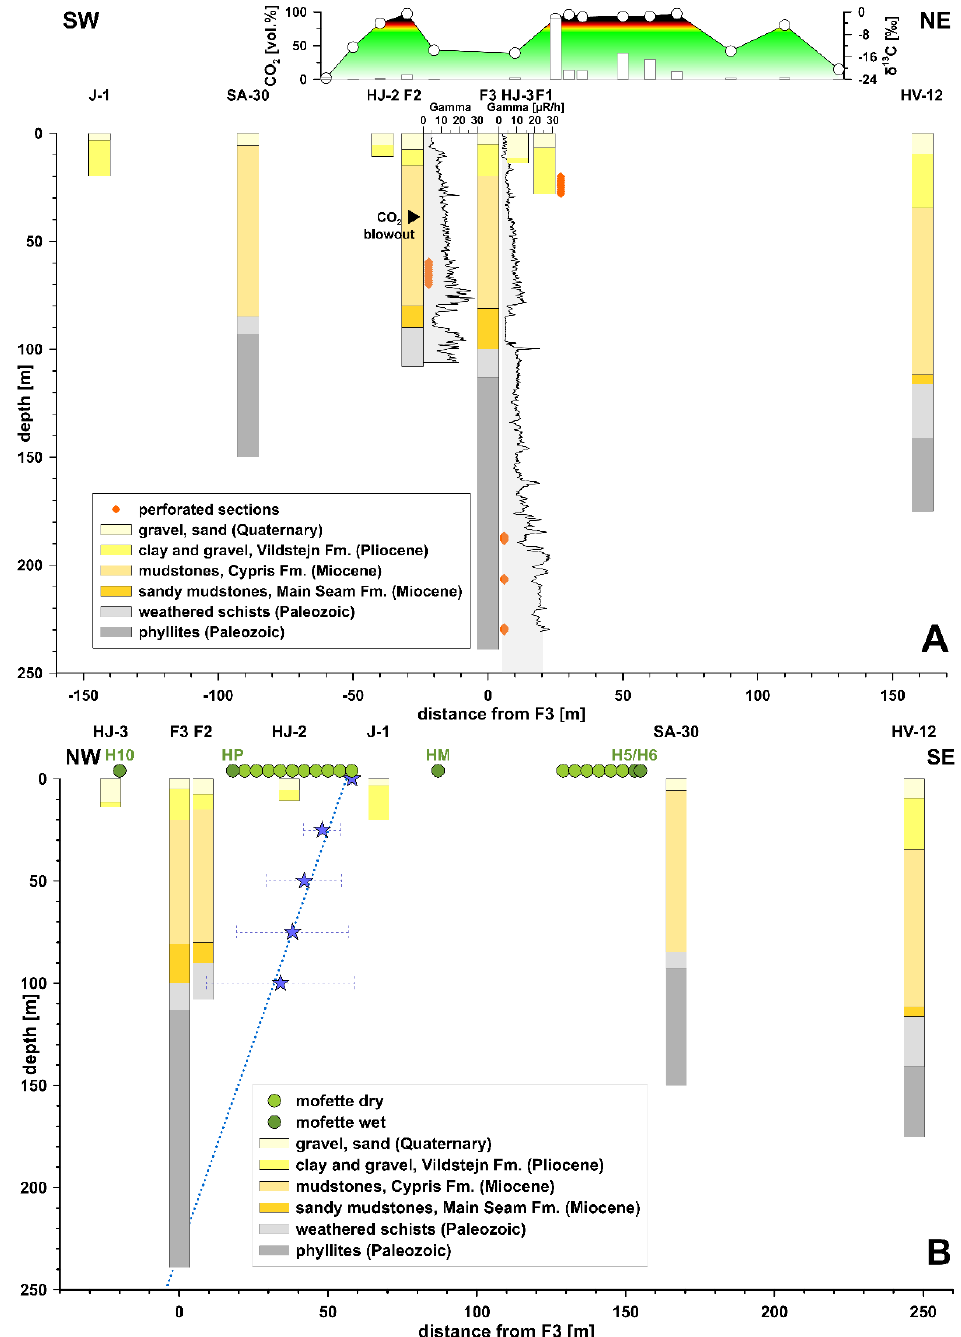
Figure 4. Lithologic and stratigraphic units from drillholes along two transects through the Hartoušov mofette field compiled from Bussert et al. [29], the GDO database of the Czech Geological Survey, and own data for F1, F2, and F3. Site IDs are given at the top of each figure; their locations are shown in Figure 3. ( A ) SW–NE profile with gamma logs shown for F2 and F3. Inset: Soil CO 2 concentrations at 0.4 to 0.8 m depth (white bars) and δ 13 C values (white circles) along a SW–NE profile located about 20 m to the north of F3 [28]. Greenish colors indicate δ 13 C values typical for organic material, whereas red to brownish colors indicate mantle origin. ( B ) NW–SE profile; blue stars mark a channel-like structure obtained from matched field processing of seismic noise data (see Table 2 and Figure 8a in Umlauft and Korn [30]).